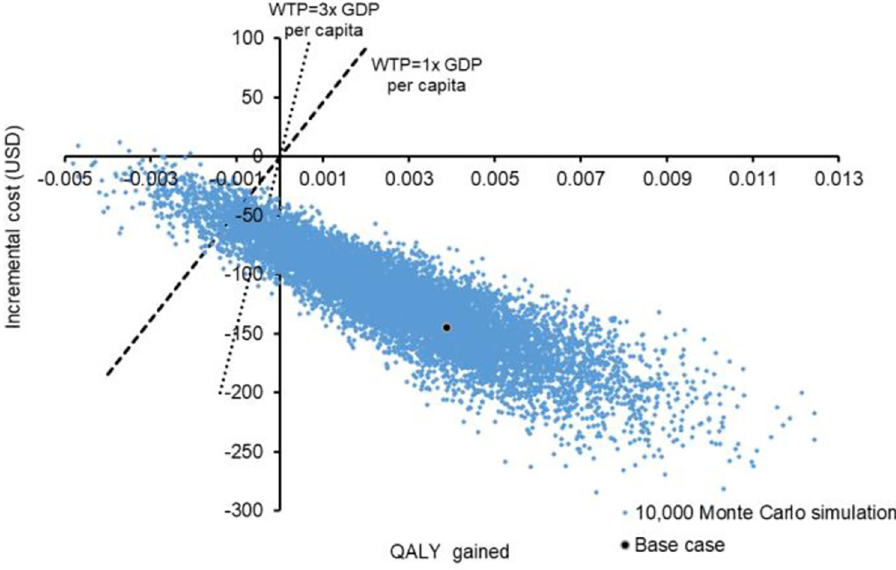
Fig 4. Scatterplot of incremental cost against QALYs gained by i-CBT versus f-CBT. f-CBT: face-to-face cognitive- behavioral therapy; i-CBT: internet-based cognitive-behavioral therapy; QALY: quality-adjusted life-year.